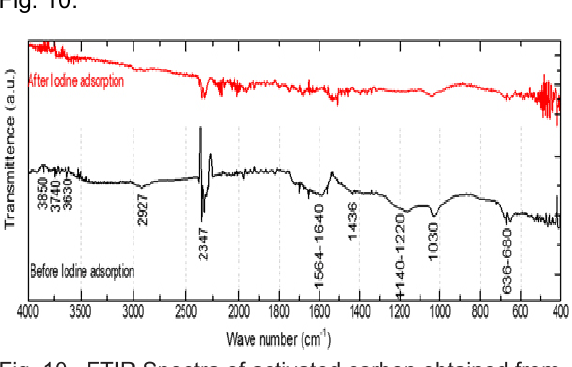
Fig. 10. FTIR Spectra of activated carbon obtained